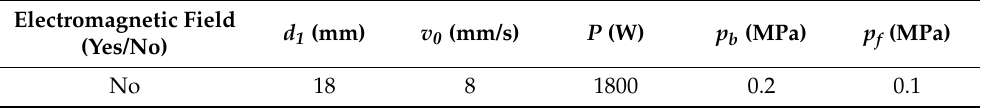
Figure 5. Structures of specimens without electromagnetic field assistance. ( a ) The overall morphol- ogy of the sample; ( b ) microstructure at point A; ( c ) microstructure at point D. Table 5. Process parameters.